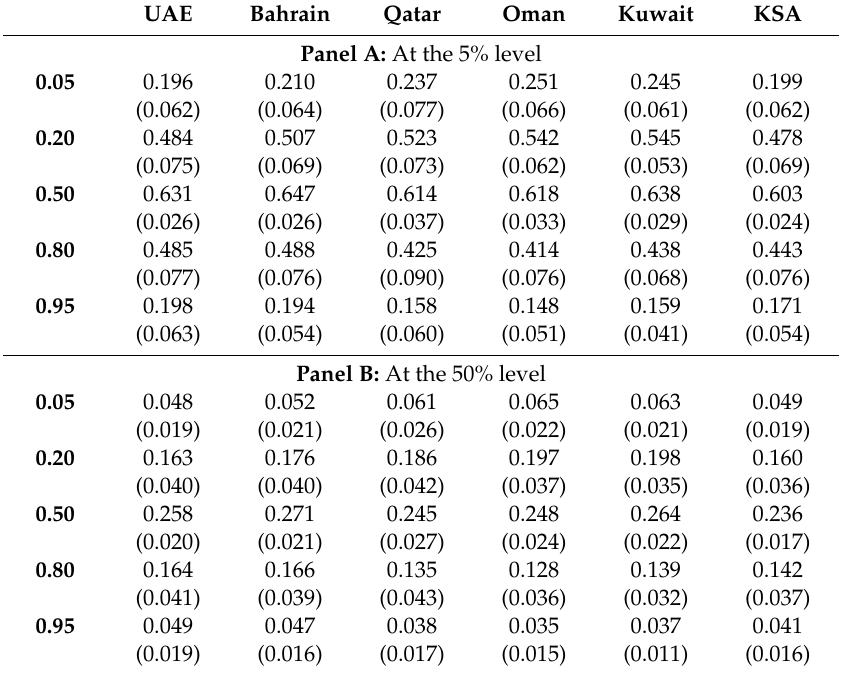
Table 4. Diversification benefits of GCCs for di ff erent portfolio compositions and probabilities. UAE